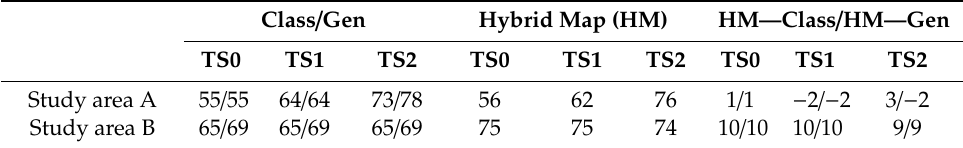
Table 13. Overall accuracy (%) of the: (1) Classification results (Class) and the generalized maps (Gen) obtained with the samples TS0, TS1 and TS2; (2) of the hybrid maps (HM) using the data produced with OSM2LULC and the classification results obtained with TS0, TS1 and TS2; and (3) the di ff erence between: the overall accuracy obtained for the hybrid maps and the classification results (HM-Class); and the hybrid maps and the generalized maps